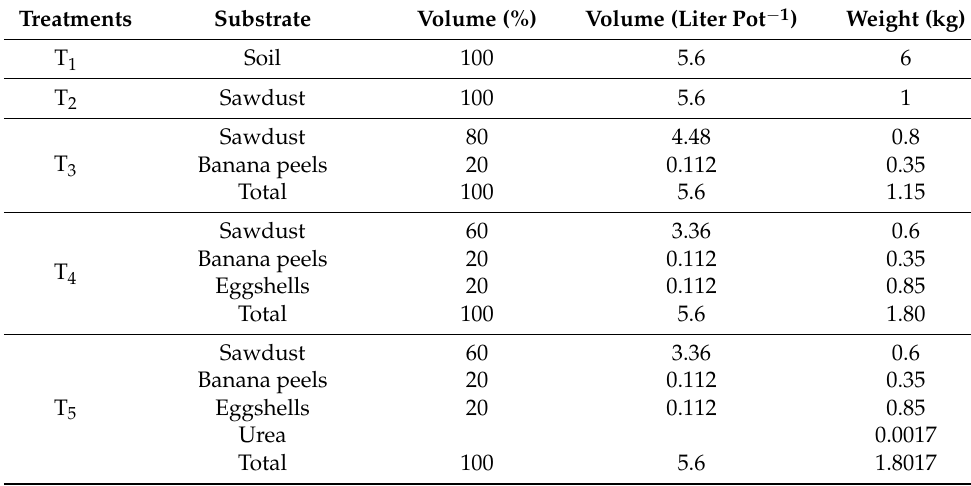
Table 2. Total quantity and composition of non-composted Bombax ceiba (Cotton tree) sawdust substrate mixtures utilized in each pot for the two trials. All treatments (T 1 , T 2 , T 3 , T 4 , T 5 ) were the same as described in Table